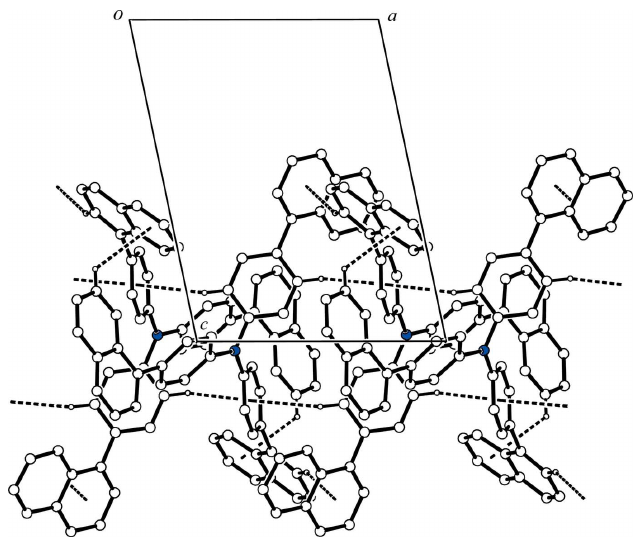
Figure 4 A packing diagram of the title compound viewed along the b axis, showing the column structure. The C—H (cid:2)(cid:2)(cid:2) (cid:2) interactions are shown as dashed lines. H atoms not involved in these interactions have been omitted for clarity.